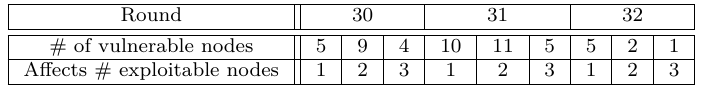
Table 13: Results for SIMON32/64 implementation.